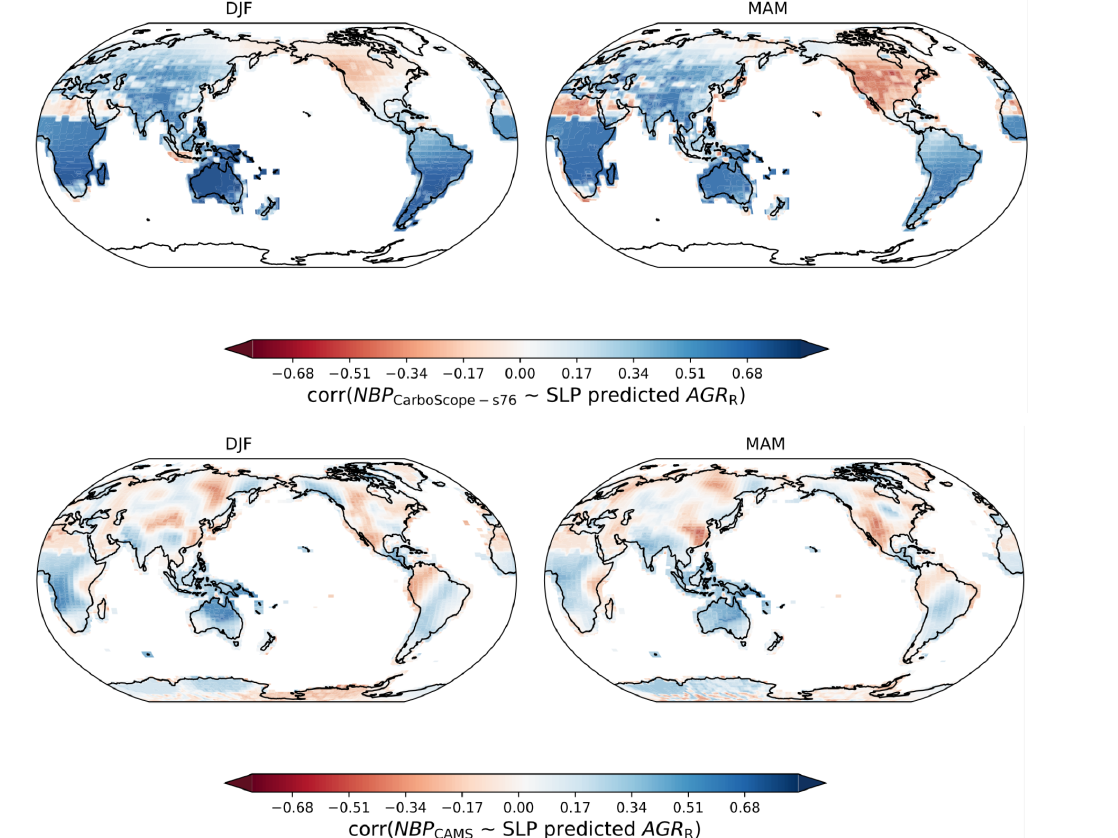
Figure A12. The spatial distribution of Pearson correlations between global DJF–MAM SLP-predicted AGR R (one time series) with pixel- based annual sum NBP variation (LOWESS detrended) from the atmospheric inversion CarboScope s76 (Bastos et al., 2020; Chevallier et al., 2005; Rödenbeck et al., 2003) (upper panel) and CAMS (Bastos et al., 2020; Chevallier et al., 2005; Rödenbeck et al., 2003) (lower panel) in the period 1980–2017.